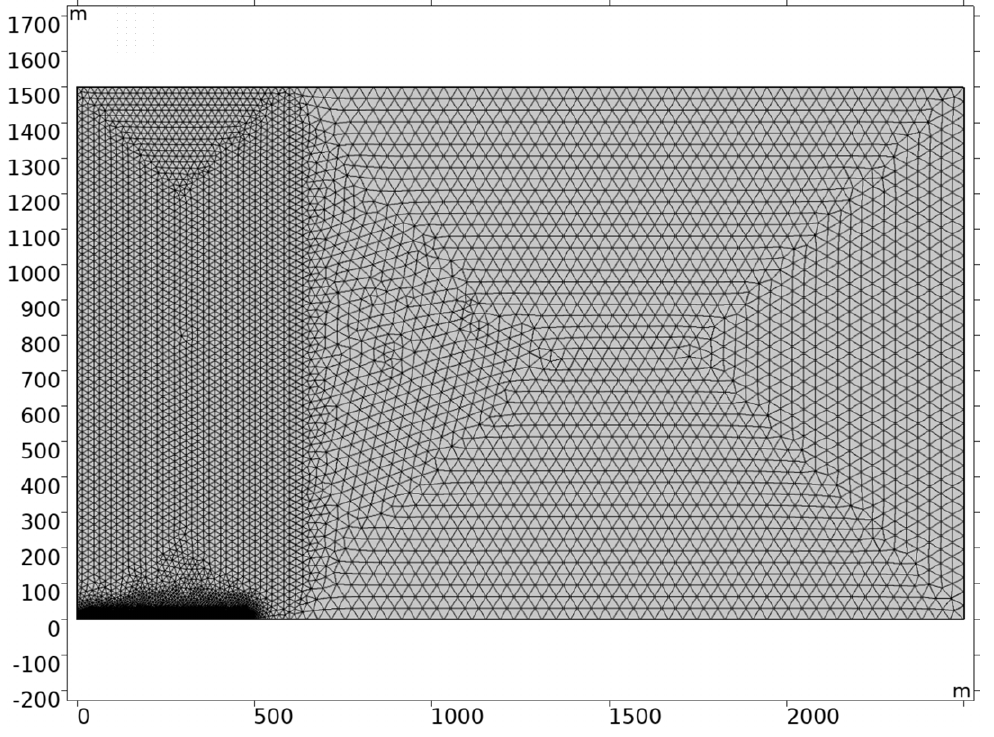
Figure B1: Mesh geometry in the models with a single thick